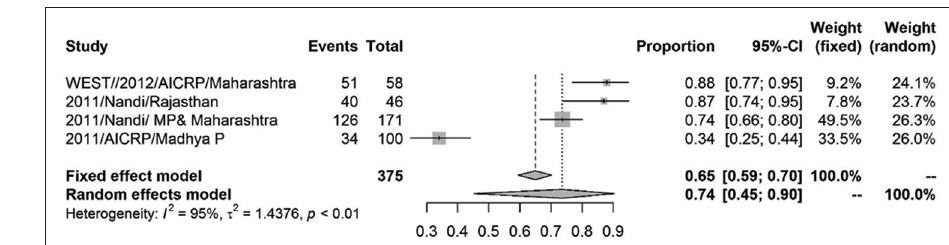
Figure-5: Forest plot of north zone classical swine fever prevalence.